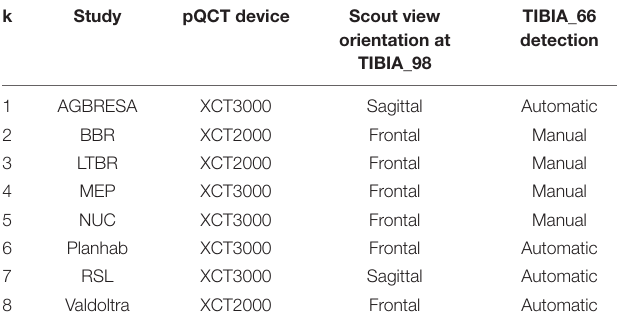
TABLE 2 | Overview about the way of the determination of the measurement site of TIBIA_98 and TIBIA_66.